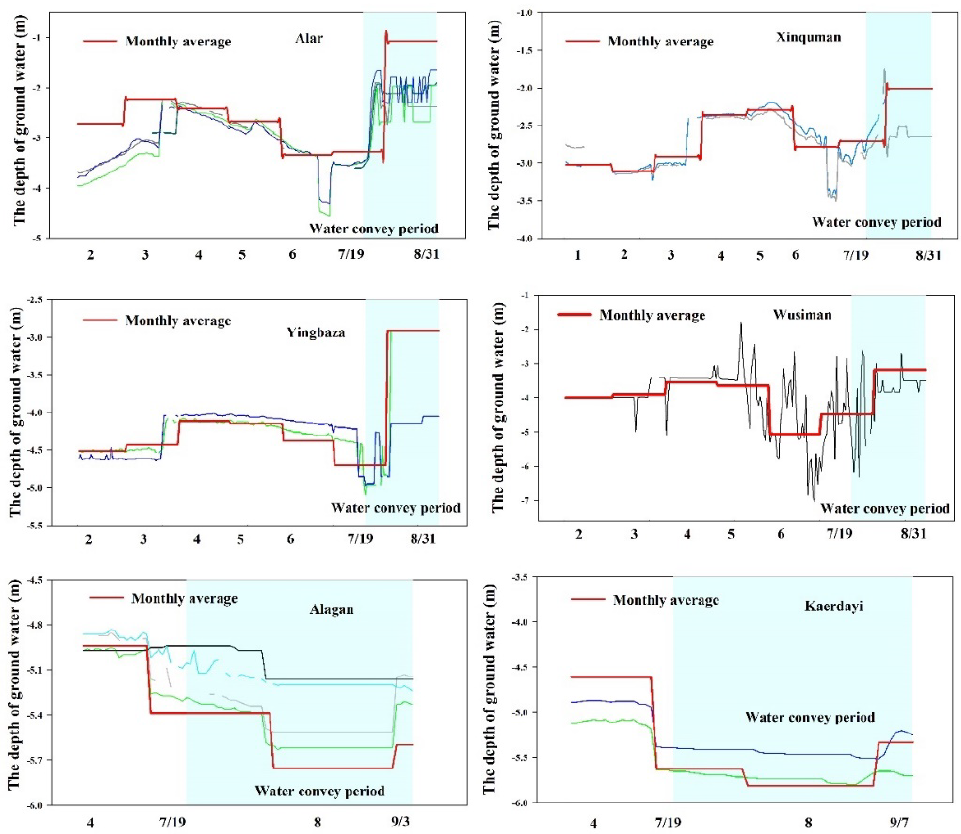
Figure 6. Variation of groundwater depth in the mainstream area of the Tarim River in